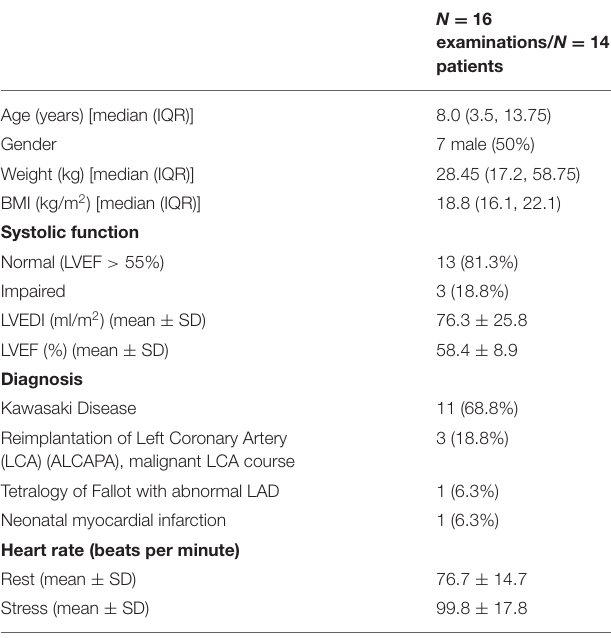
TABLE 1 | Demographic and baseline